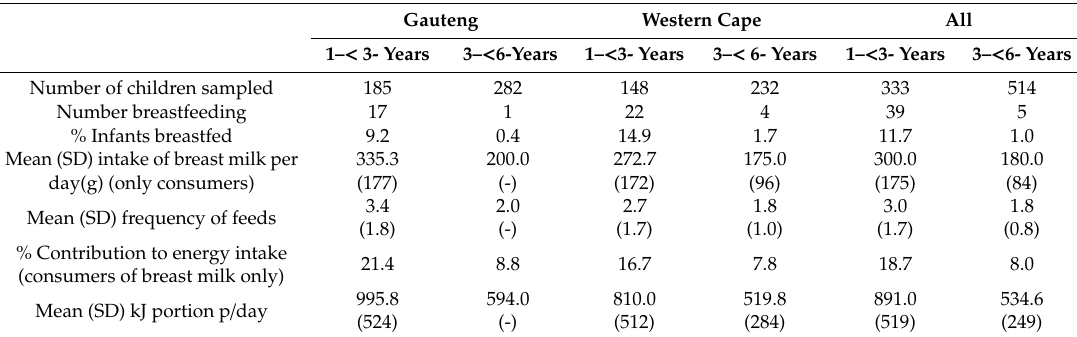
Table 6. Children still receiving breast milk by age group and